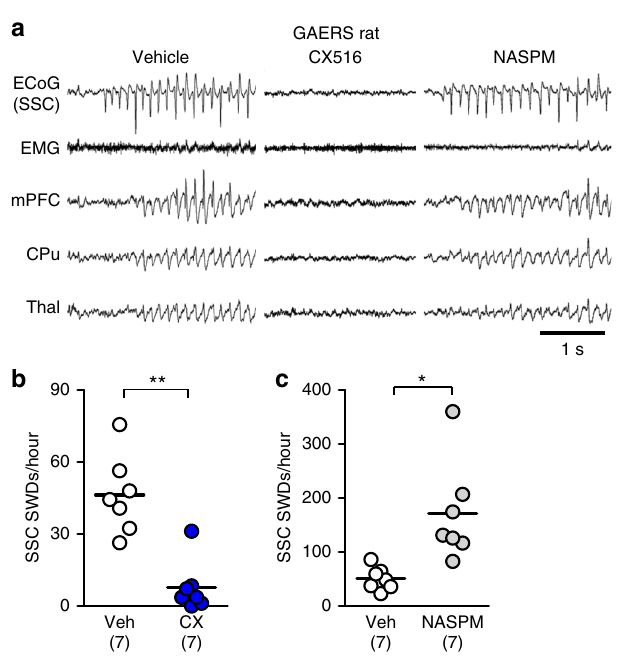
Fig. 8 Facilitation and blockade of cortico-striatal excitatory transmission suppresses and aggravates SWDs in GAERS rats. a Representative ECoG or LFP recordings in GAERS rat with vehicle, CX516 and NASPM injections. b , c Microinjection of CX516 into the striatum (1.5 µ l, bilateral) suppressed SWDs ( b ), while NASPM injections into the striatum (1.5 µ l, bilateral) aggravates SWDs in GAERS rats ( c ). Vehicle ( N = 7) vs. CX516 ( N = 7), unpaired t test with Welch ’ s correction, number of SWDs for 3000 sec after injection: t 10 = 5.218, ** P = 0.0004; total duration of SWDs: 401.5 ± 67.0 sec (vehicle), 24.6 ± 17.6 sec (CX516), t 6 = 5.439, ** P = 0.0016. b , Vehicle ( N = 7) vs. NASPM ( N = 7), unpaired t test with Welch ’ s correction, number of SWDs for 2000 sec after injection: t 6 = 3.356, * P =